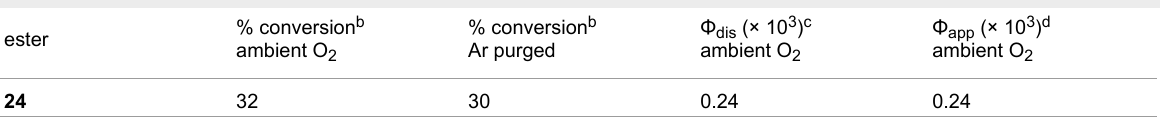
Table 3: Quantum yields and conversions of 24 with and without Ar purging. a